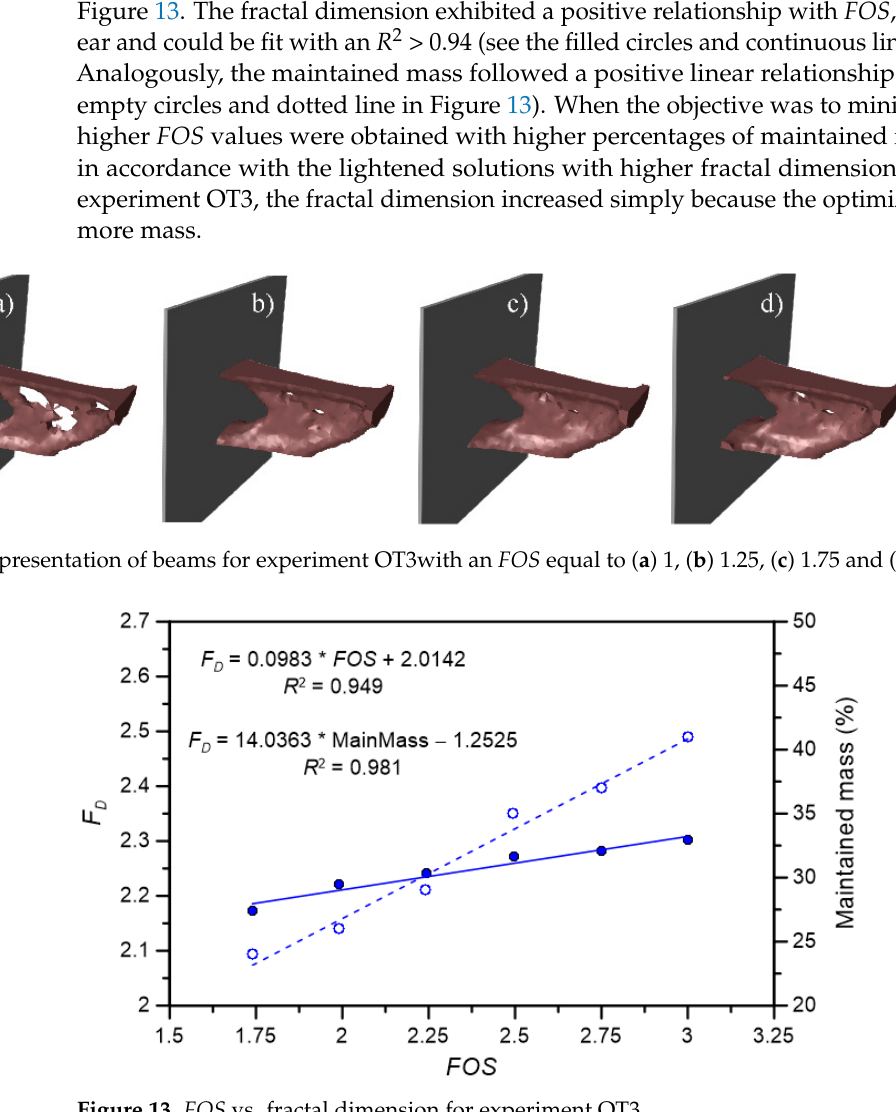
Figure 11. Thickness vs. fractal dimension for experiment OT2.